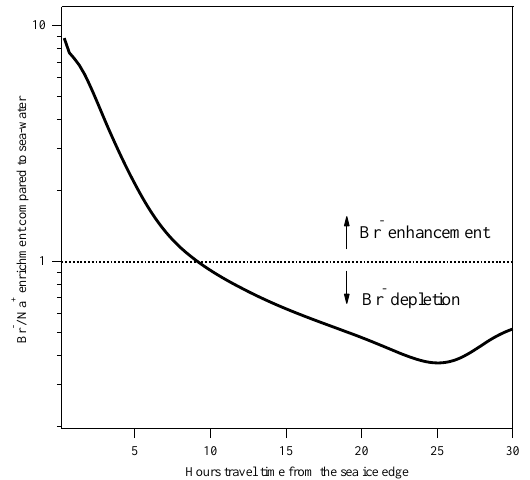
Fig. 7. Variability in the observed Br/Na ratios expressed as a func- tion of the air mass travel time due to the different deposition veloci- ties of HBr and sea salt in the model. After 8h of transport, bromide begins to be depleted relative to sea salt.